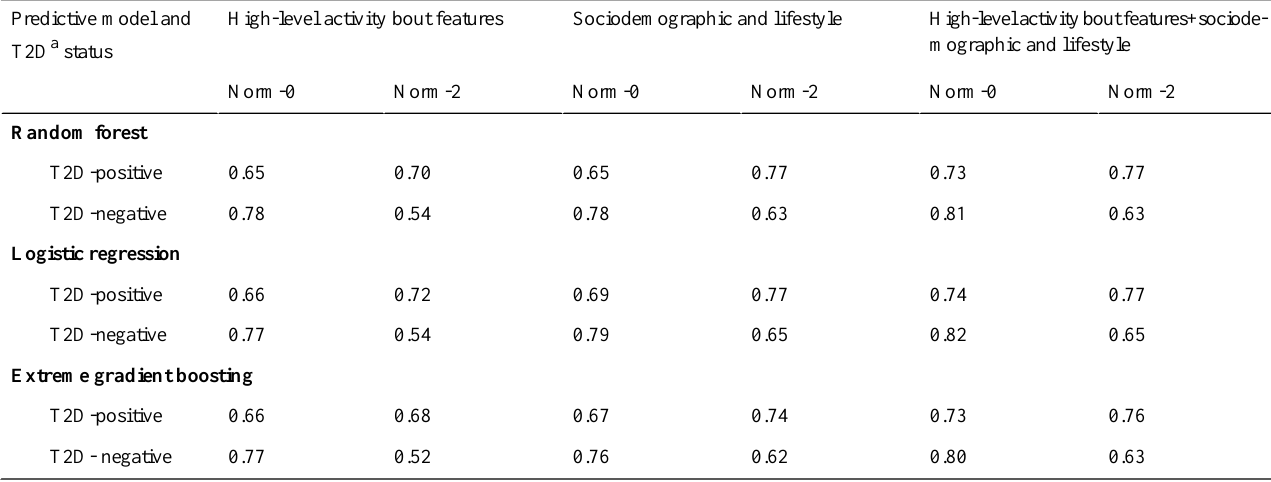
Table 4. Classification results measured using F1, showing the effect of choice of type 2 diabetes-negatives, Norm-0 (no physical activity impairment) versus Norm-2 (severe physical activity impairment). The values in the cells represent F1